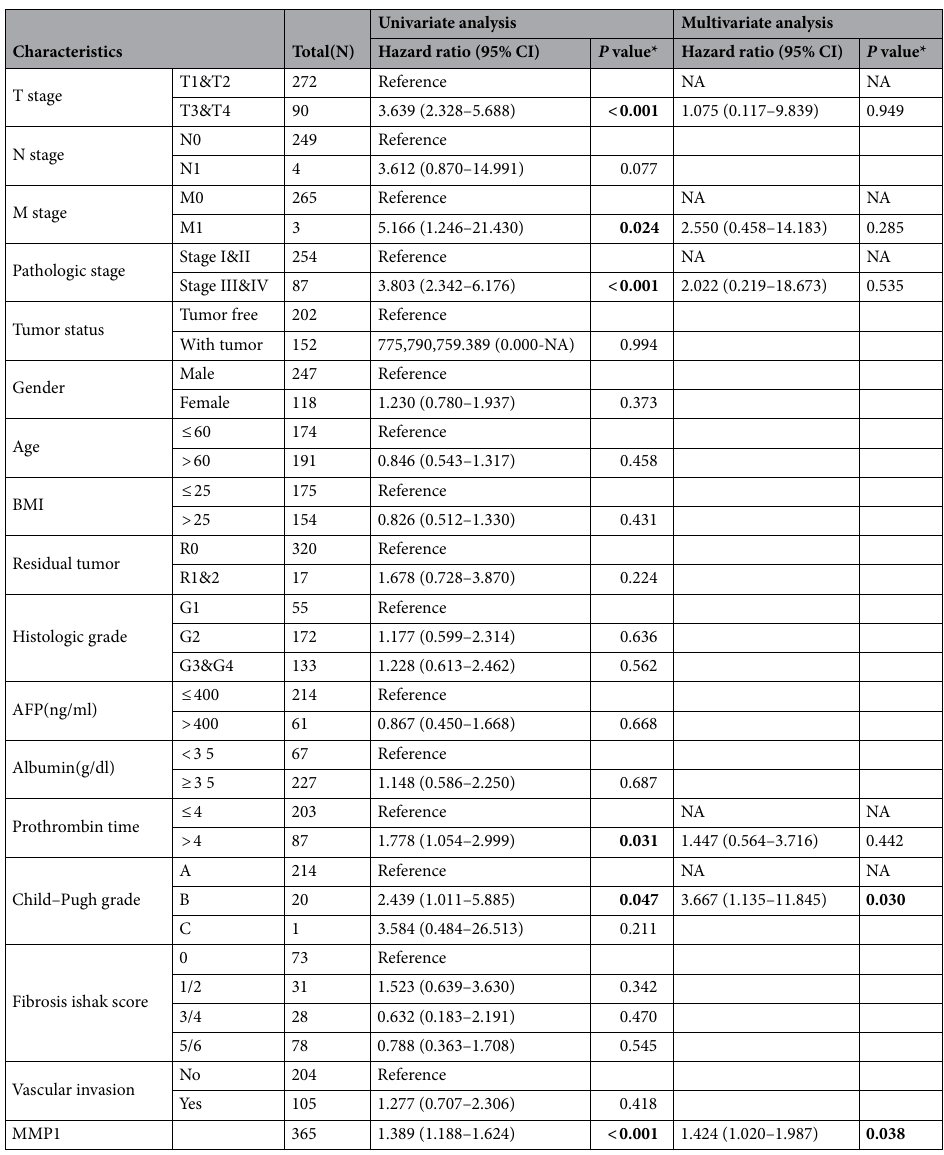
Table 5. The univariate and multivariate analysis for the DSS. DSS disease specific survival, CI confidence interval, NA reference group or could not be evaluated. *Compared with each group (Log-Rank test or Omnibus test for univariate, Cox regression analysis with adjusted hazard for multivariate). p < 0.05 means statistically significant (highlighted in